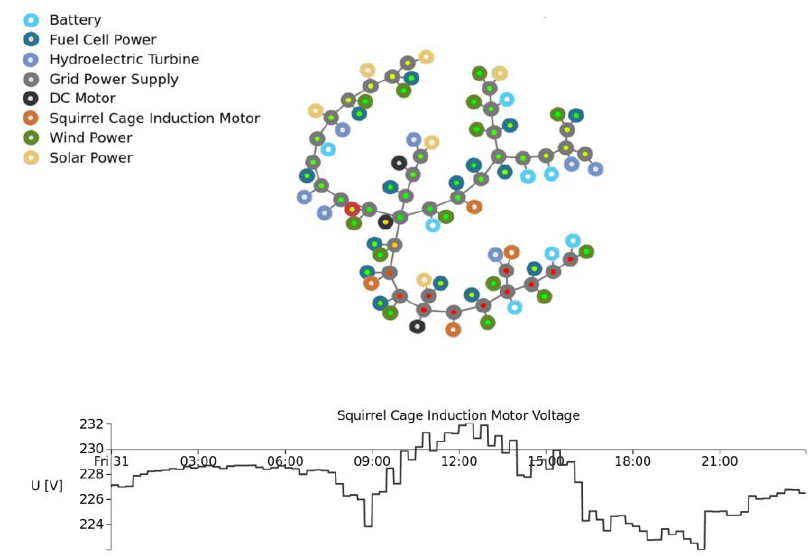
Figure 24. Mosaik co-simulation: SCIM RMS Voltage.